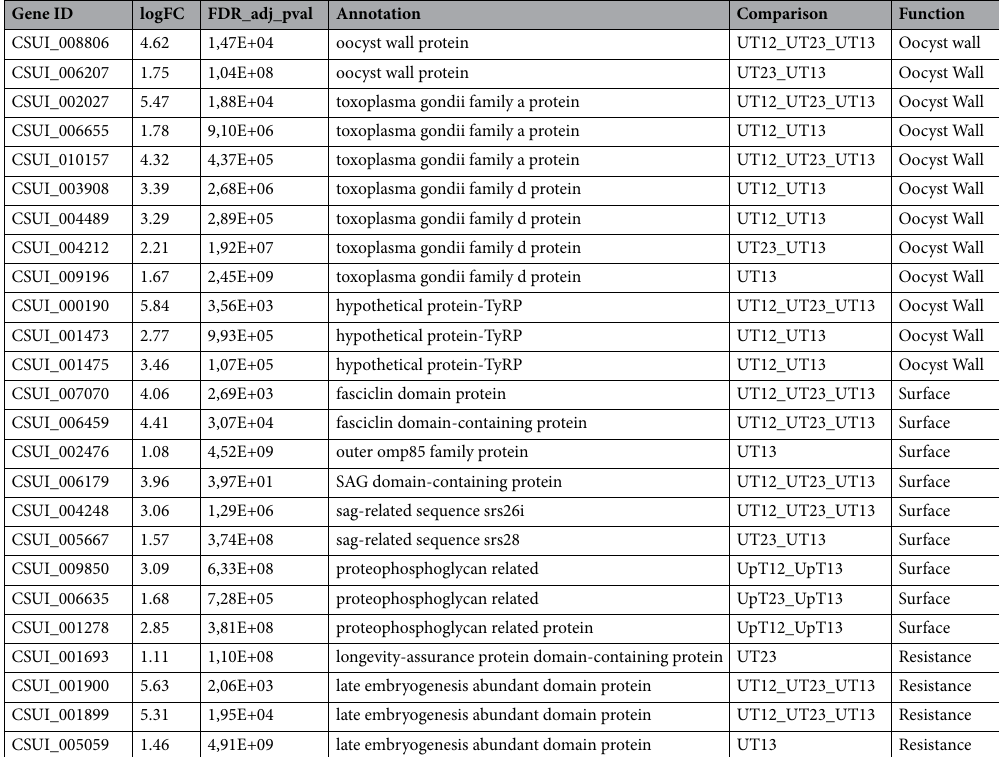
Table 1. Upregulated transcripts coding for proteins with known or putative roles in oocyst wall composition and surface. They are listed along with their transcript abundance (LogFC), annotation, comparison (upregulated transcripts (UT) in early sexual stages(2) compared to merozoites(1), UT12, late sexual stages (3) compared to merozoites (1), UT13, and late sexual stages (3) compared to early sexual stages(2), UT23) and biological